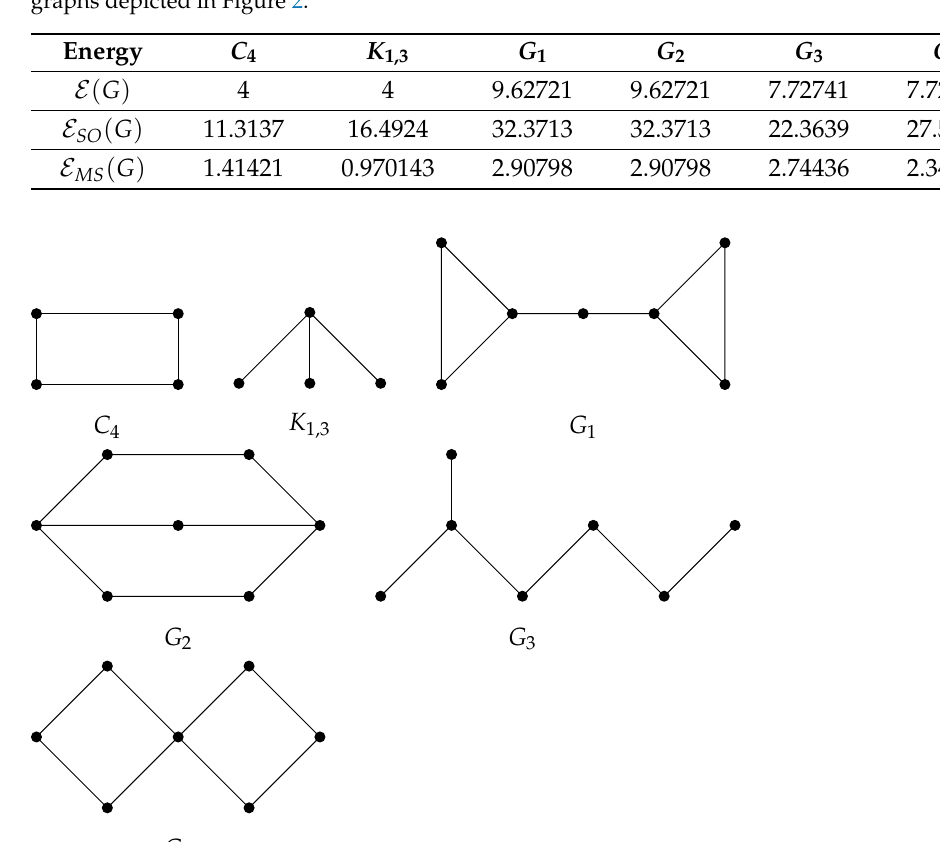
Figure 2. Three pairs of equienergetic chemical graphs of the order of at most 7, namely { C 4 , K 1,3 } , { G } , and { G } . Among these three pairs, { C 3 , G 4 1 , G 2 equienergetic graphs nor modified Sombor equienergetic graphs.